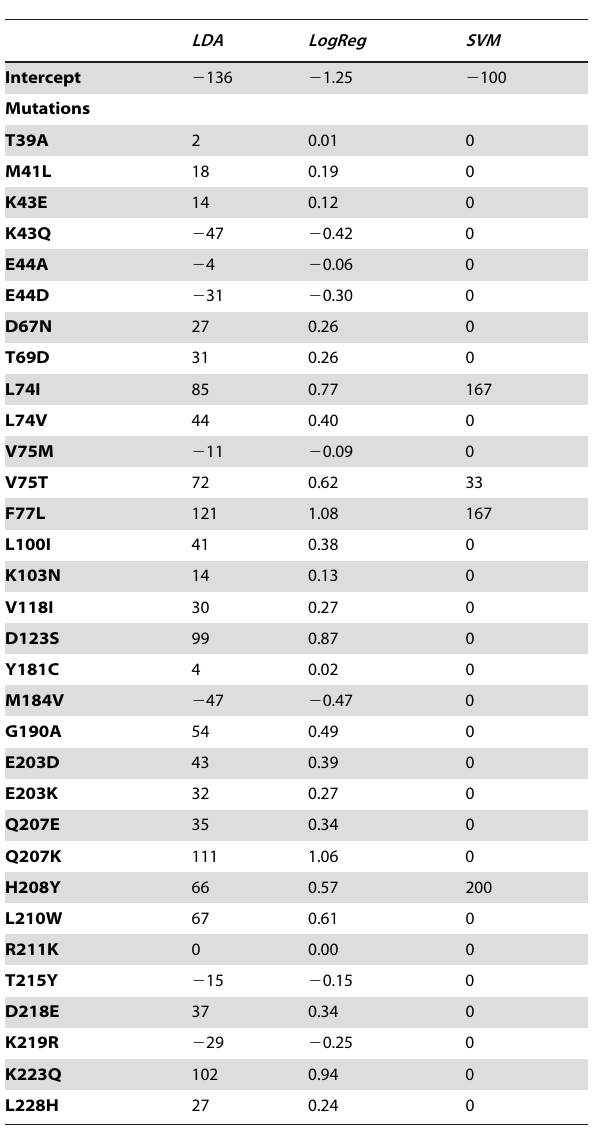
Table 1. Estimated weights associated with the 32 mutations retained on the entire data set for the three statistical methods investigated (LDA: Linear Discriminant Analysis; LogReg: Logistic Regression, SVM: Support Vector Machine).